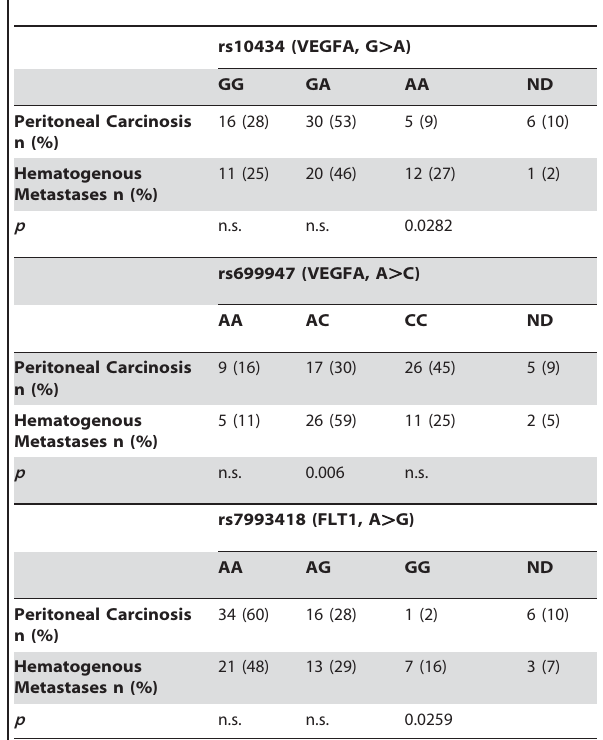
Table 4. Global results for tumour VEGF and VEGF-R polymorphisms and either peritoneal-only diffusion or hematogenous metastases at univariate